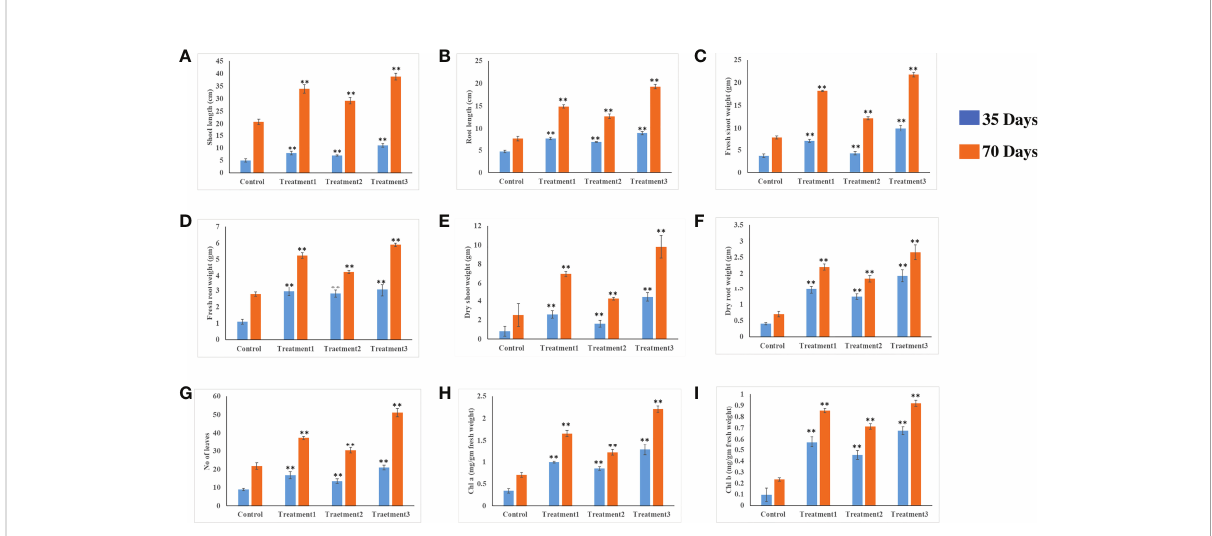
FIGURE 8 In vivo plant growth-promoting effect of endophytic actinobacterial isolates on chili plants. Treatment 1-VCLA3 Treatment 2-RVRA7, Treatment 3-VCLA3+RVRA7 (A) Shoot length (cm), (B) root length (cm), (C) Shoot weight fresh (g), (D) Root weight fresh (g), (E) Shoot weight dry (g), (F) Root weight dry (g), (G) No of leaves, (H) Chlorophyll a (mg/g fresh weight), (I) Chlorophyll b (mg/g fresh weight) after 35 and 70 days of inoculation. The values are mean ± Standard error ( n = 5). ∗∗ Represents statistical signi fi cance ( p < 0.05, One-way